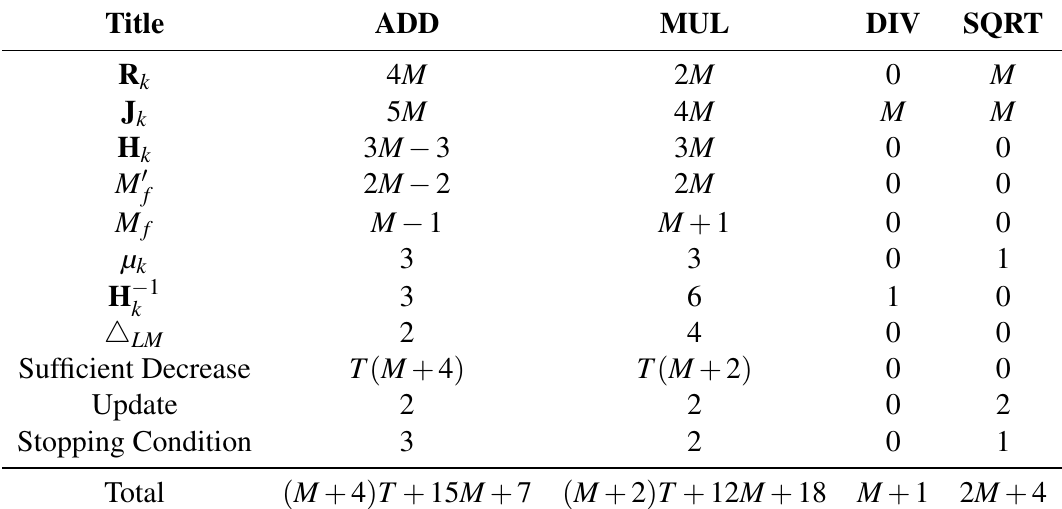
Table 1. LM Cost